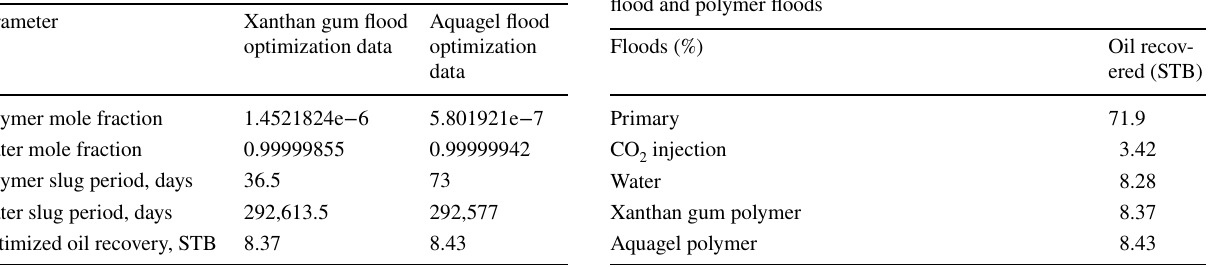
2 injection, water-